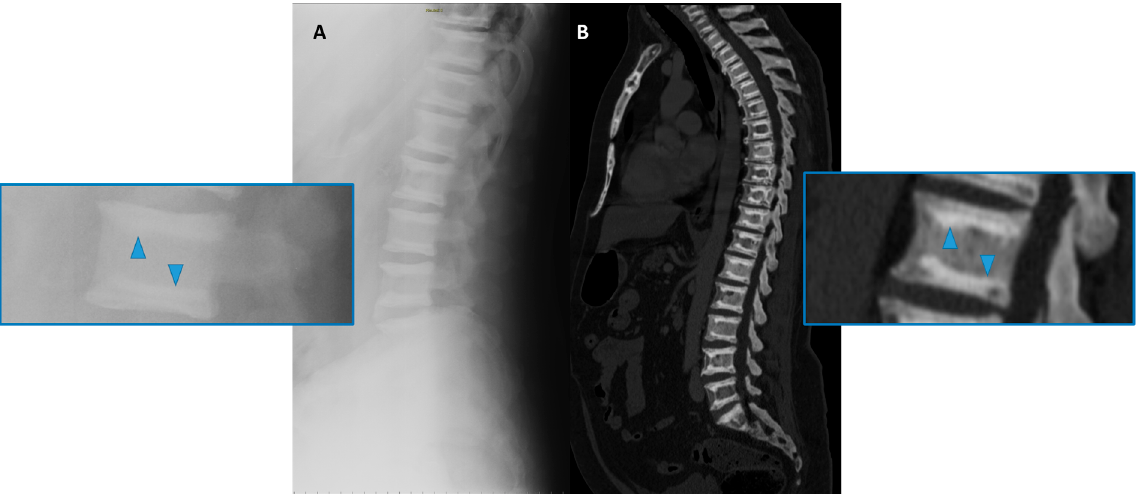
Figure 4. Conventional radiography (lateral projection, ( A )) and Computed Tomography (CT Sagittal reconstruction, ( B )) of the spine of a 50-year-old male affected by osteopetrosis (ADO type 2). Well-defined areas of increased bone density are detectable on the vertebral endplates (arrowhead), configuring the so-called ‘sandwich vertebrae’ appearance.